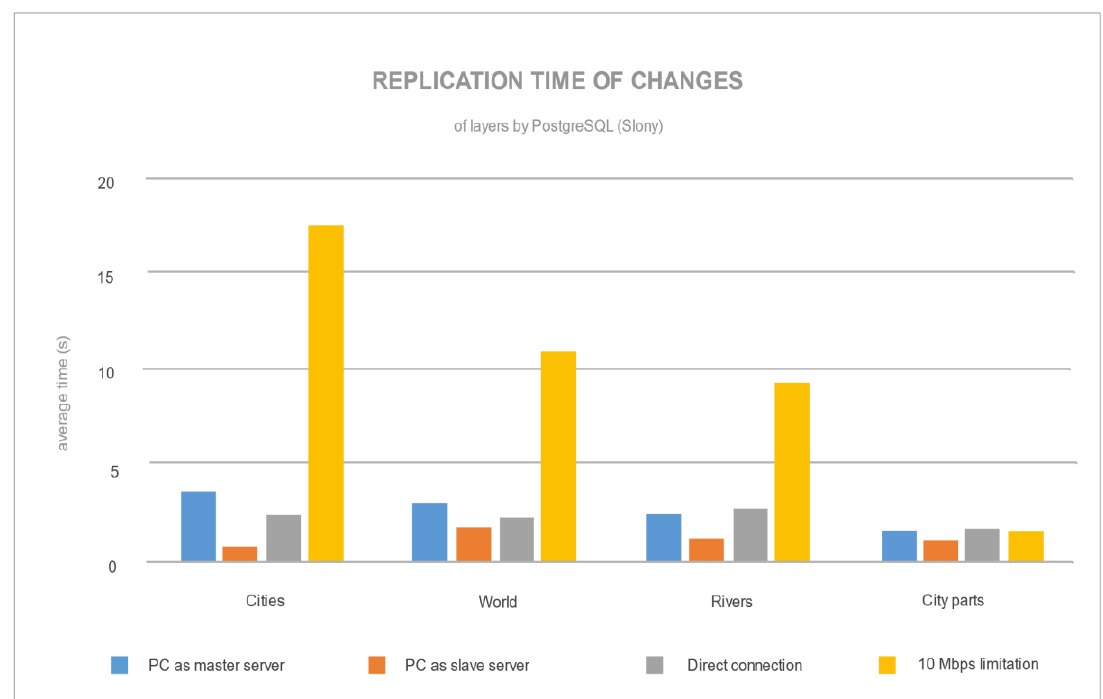
Figure 13. Average replication time of layers with different cluster configurations by PostgreSQL (Slony).